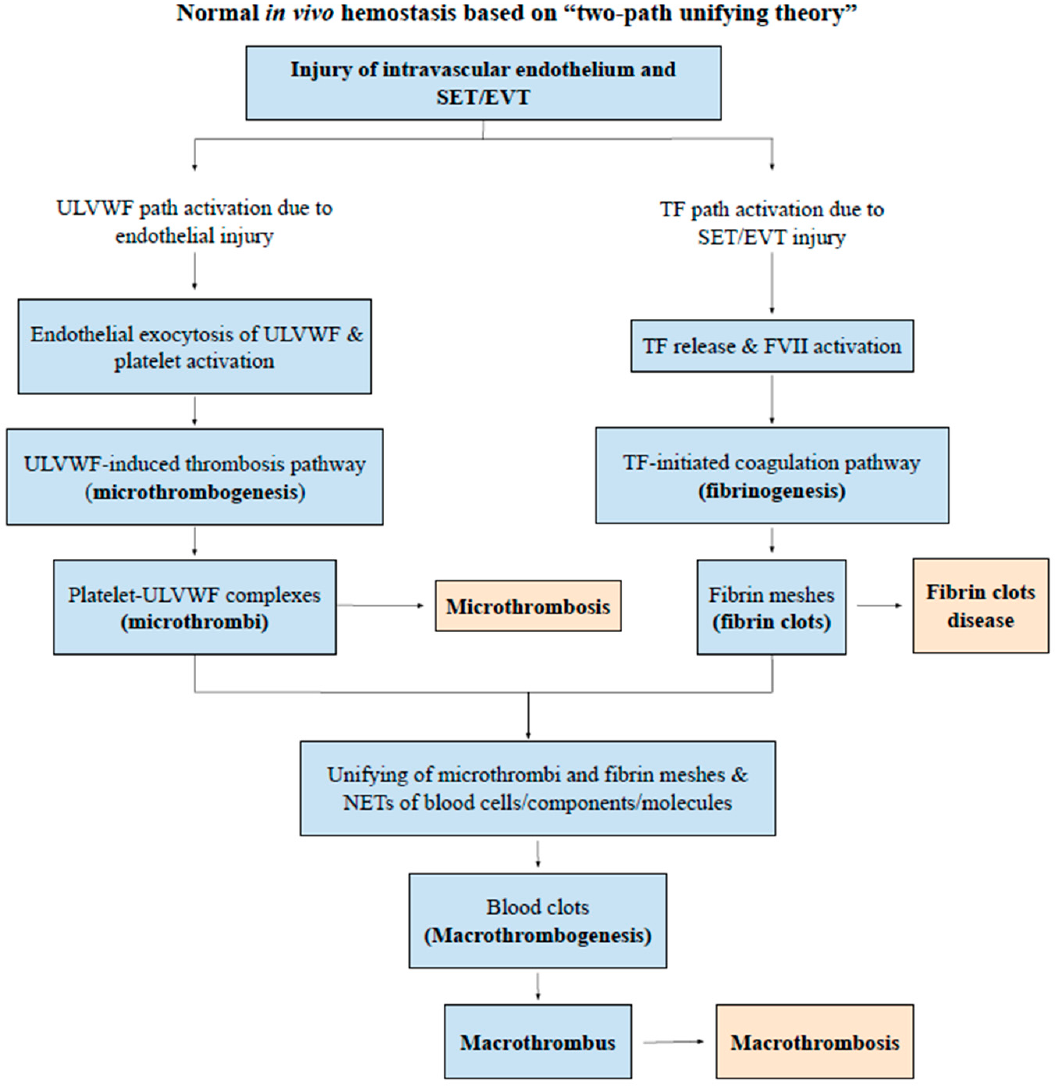
Figure 1. Normal in vivo hemostasis based on “two-path unifying theory” (Reproduced and modified with permission from Chang JC. Thrombosis Journal. 2019;17:10). Legends/Captions: Following a vascular injury, in vivo hemostatic system activates two independent sub-hemostatic paths: microthrombotic (ULVWF) and fibrinogenetic (TF). They are initiated by the damage of ECs and/or SET/EVT in a external bodily injury and intravascular injury. In the activated ULVWF path from ECs damage, ULVWF multimers are released and recruit platelets, and produce microthrombi strings via microthrombogenesis, but in the activated TF path from SET/EVT damage, released TF activates FVII and produces fibrin meshes via extrinsic coagulation cascade. The final path of in vivo hemostasis is macrothrombogenesis, in which microthrombi strings and fibrin meshes become unified together with incorporation of NETs, including red blood cells, neutrophils, DNAs and histones. This unifying event macrothrombogenesis promotes hemostatic plug formation and wound healing in external bodily injury and produces macrothrombosis in intravascular injury. Abbreviations: EA-VMTD, endotheliopathy-associated vascular microthrombotic disease: EVT, extravascular tissue; NETs, neutrophil extracellular traps; SET, subendothelial tissue; TF, tissue factor; ULVWF, unusually large von Willebrand